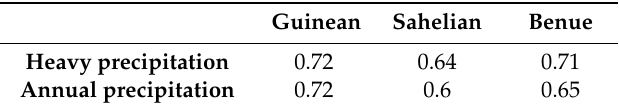
Table 1. Correlation of AMAX with heavy precipitation (95th percentile) and annual precipitation derived from WFDEI for the period from 1979–2012. All correlations are significant ( α =